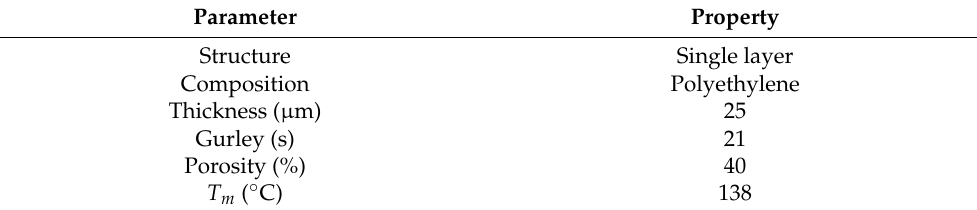
Table 1. Specifications of the porous PE substrate used for this study [29]. Parameter Property Structure